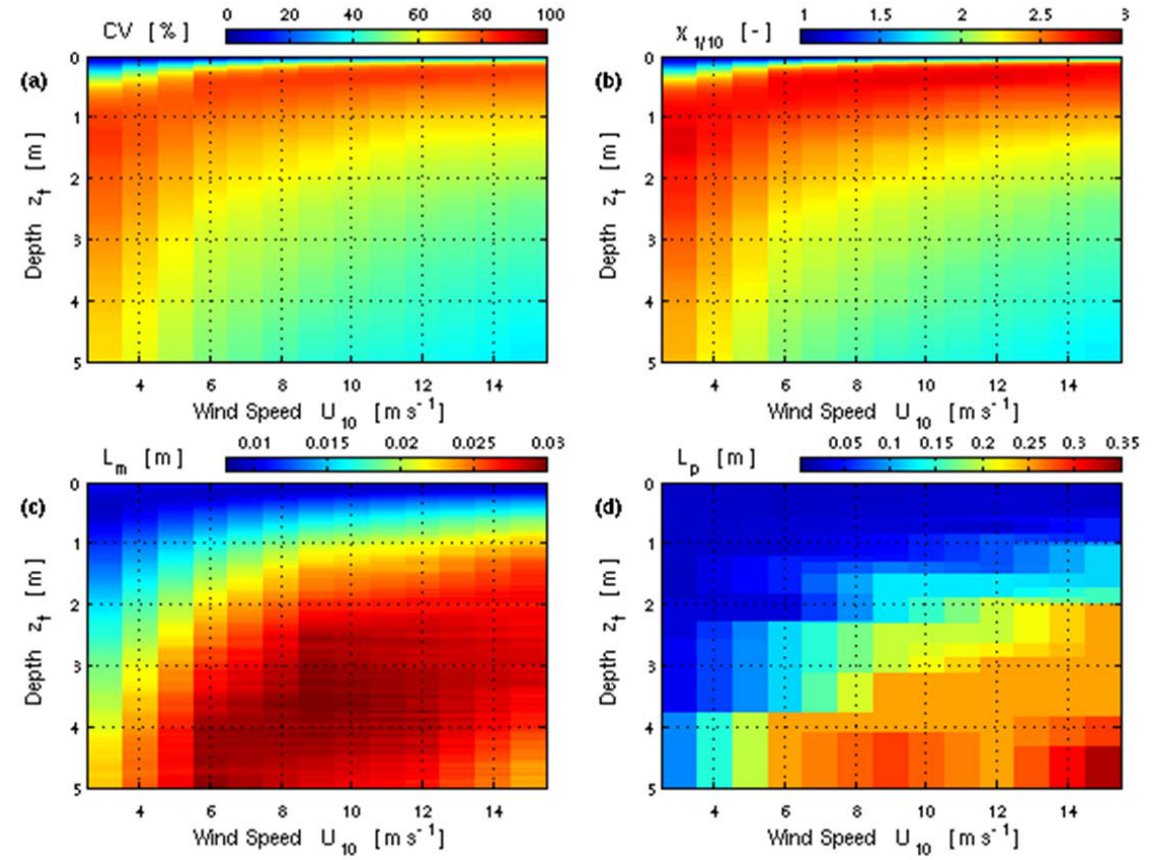
fluctuations; (b) significant irradiance 4 d ; (d) spectral peak length L m